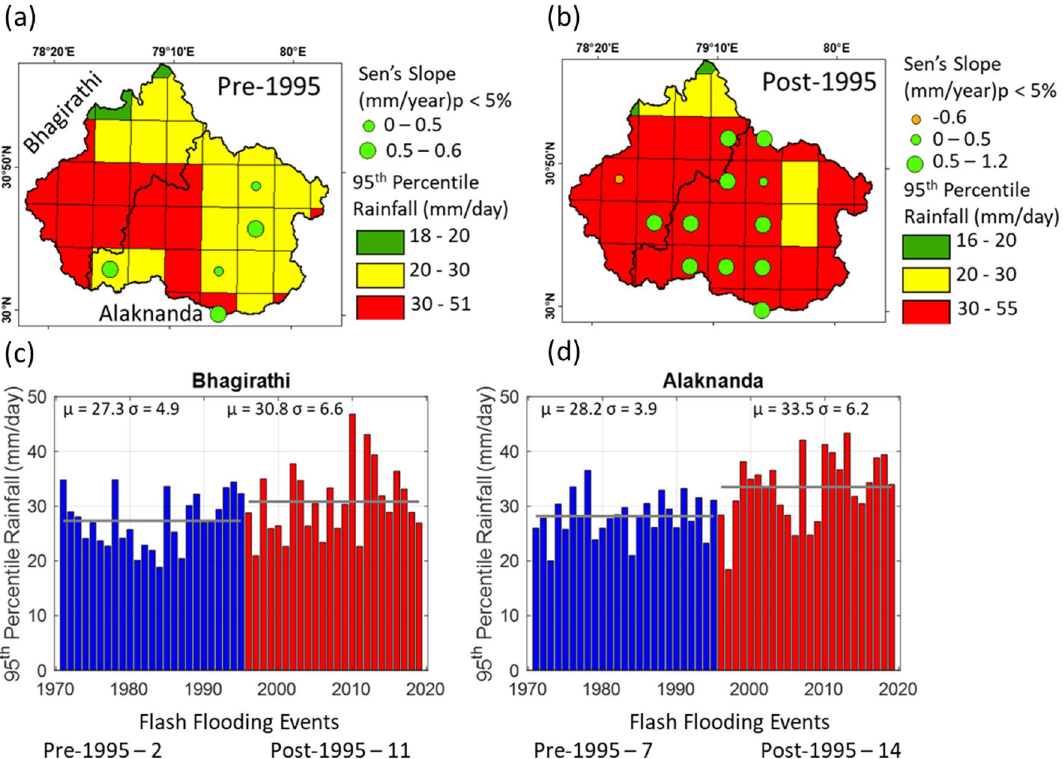
Figure 3. (a) Pre-and (b) post-1995 average 95th percentile rainfall magnitudes for 1970–2019. The different sizes of green filled circles represent the increasing Sen’s slope for the 95th percentile rainfall events at the 5% significance level. There is one orange-filled circle present in the Bhagirathi basin, which shows decreasing Sen’s slope for the 95th percentile rainfall events at a 5% significance level. (c,d) Shows bar plots 95th percentile rainfall of the Bhagirathi and Alaknanda basins for each year between 1970 and 2019. The blue and red bars show pre-and post-1995 annual cumulative rainfall magnitudes. The horizontal grey line shows the mean